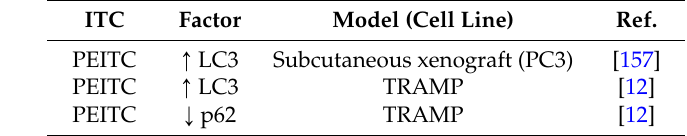
Table 7. ITCs inhibit the in vivo growth of prostate tumors by inducing autophagic cell death.